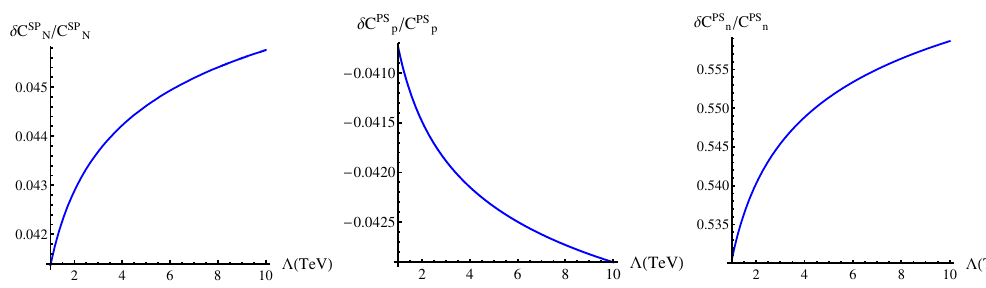
and C PS of eq. (4.5) due to QCD running p;n N